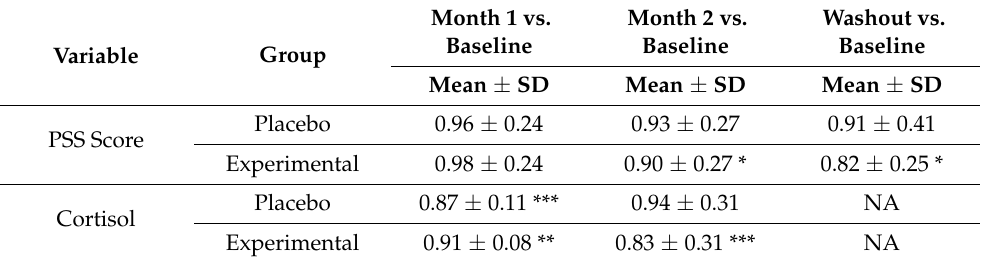
Table 5. Results of anxiety tests. Change vs. baseline = percent change from baseline. Variable Group